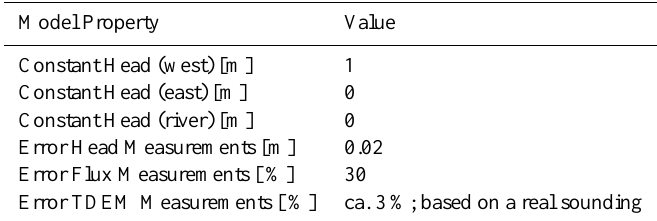
Table 1. Model properties used in the synthetic example.